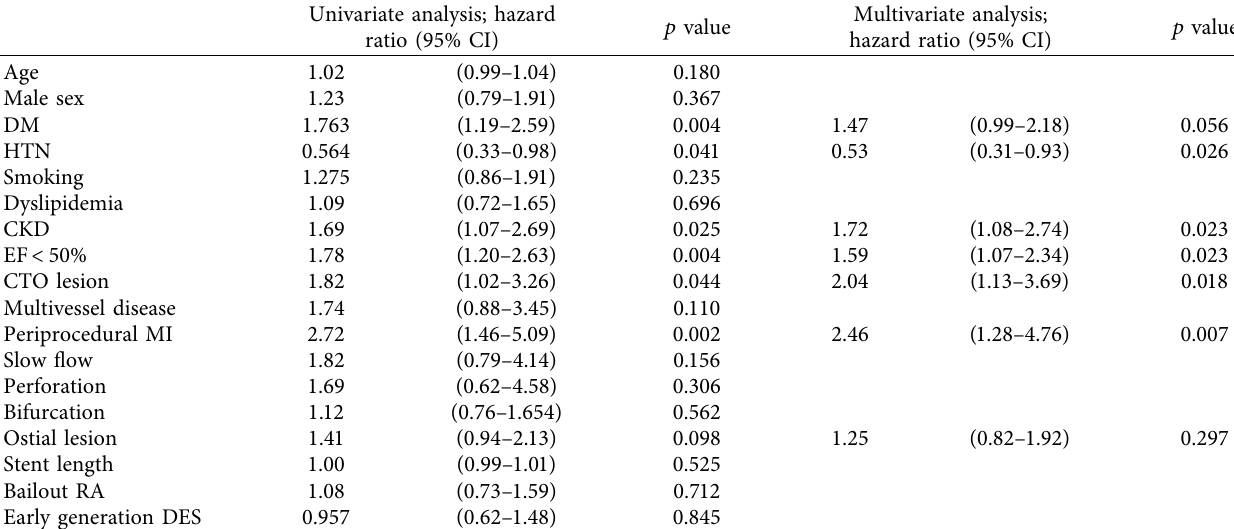
Table 5: Univariate and multivariate regression analyses identifying predictors of the long-term target lesion failure (TLF). Univariate analysis; hazard Multivariate analysis; p value ratio (95% CI) hazard ratio (95% CI)